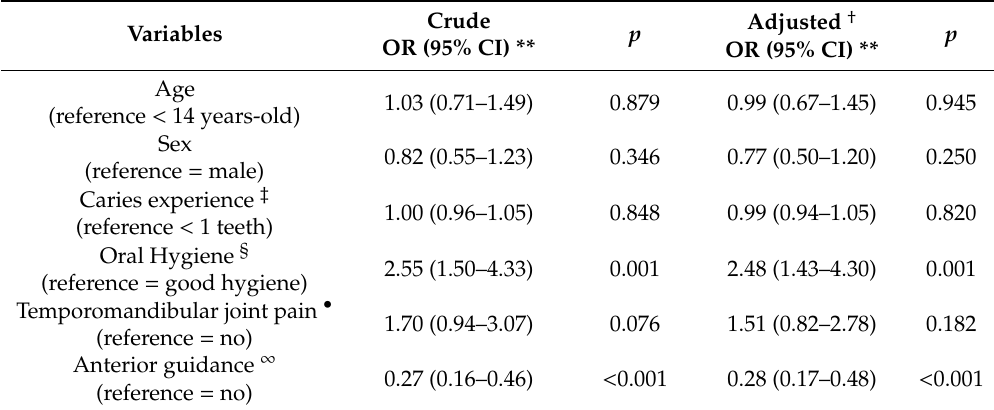
Table 3. Logistic regression model of the association between the Normative Need for Orthodontic Treatment (NNOT) prevalence* and oral health variables.